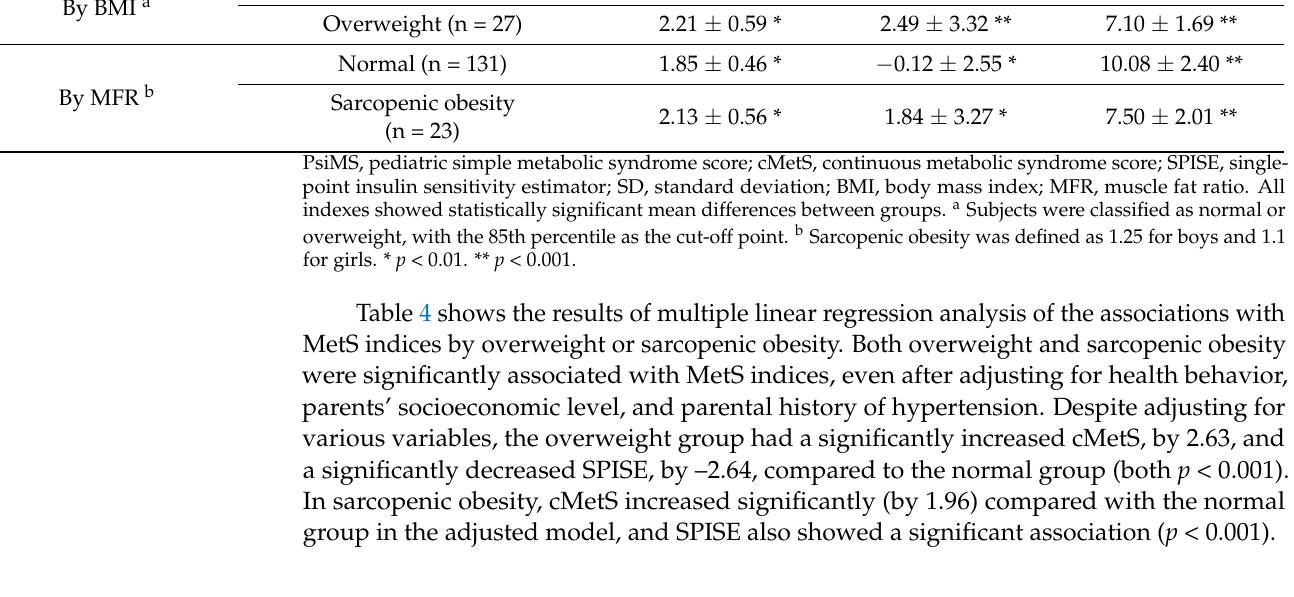
Table 3. Mean difference in the metabolic syndrome index in adolescence according to childhood overweight and sarcopenic obesity.